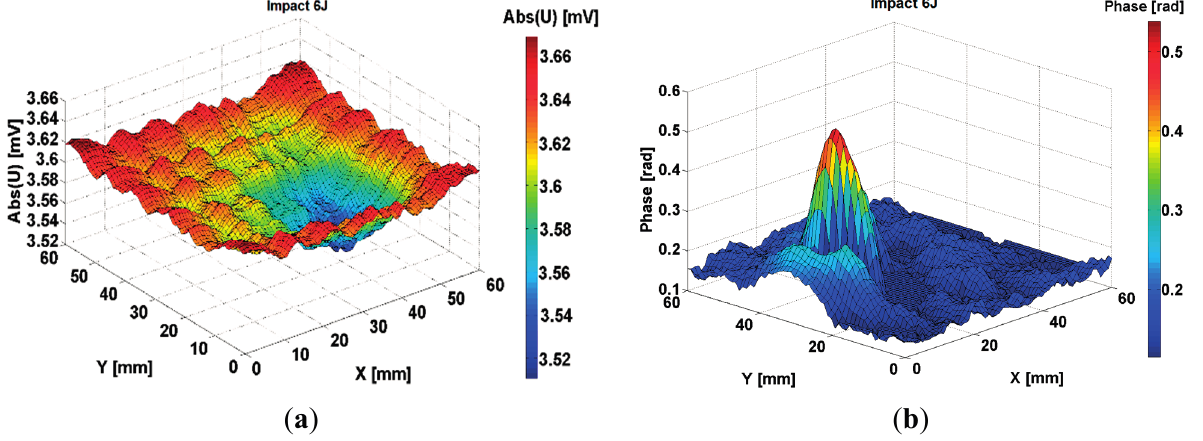
Figure 9. The measured signal delivered by the electromagnetic sensors with MM lens at scanning of composite FRPC quasi-isoptropic in plane samples impacted with 6 J energy ( a ) amplitude; ( b )